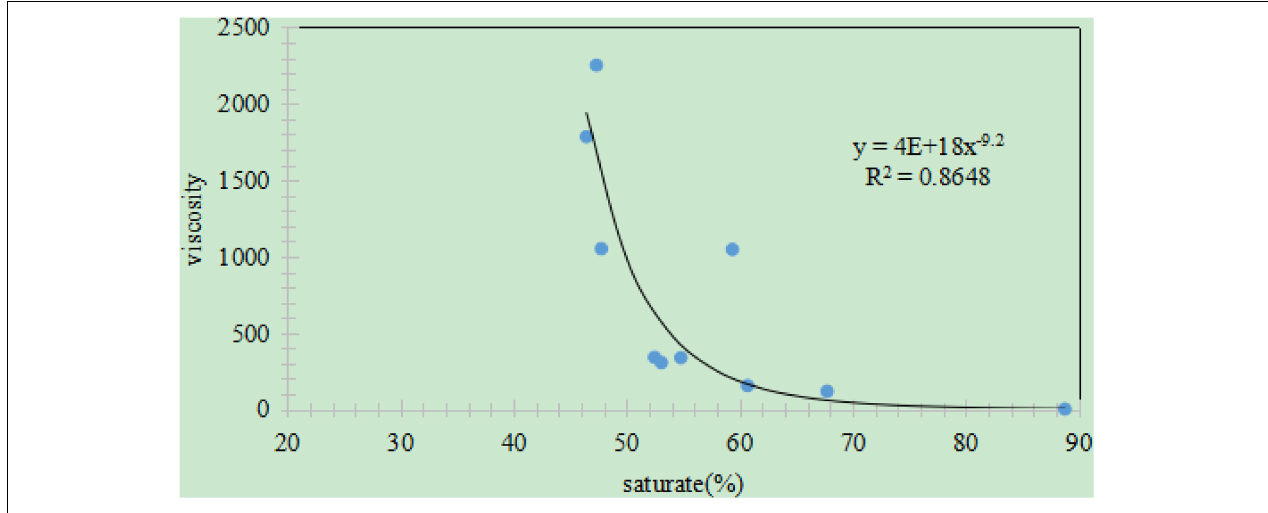
FIGURE 2 | Relationship between the content of the saturated hydrocarbon and the viscosity (20 ◦ C) for the crude oil extracted from the Jimsar Sag.